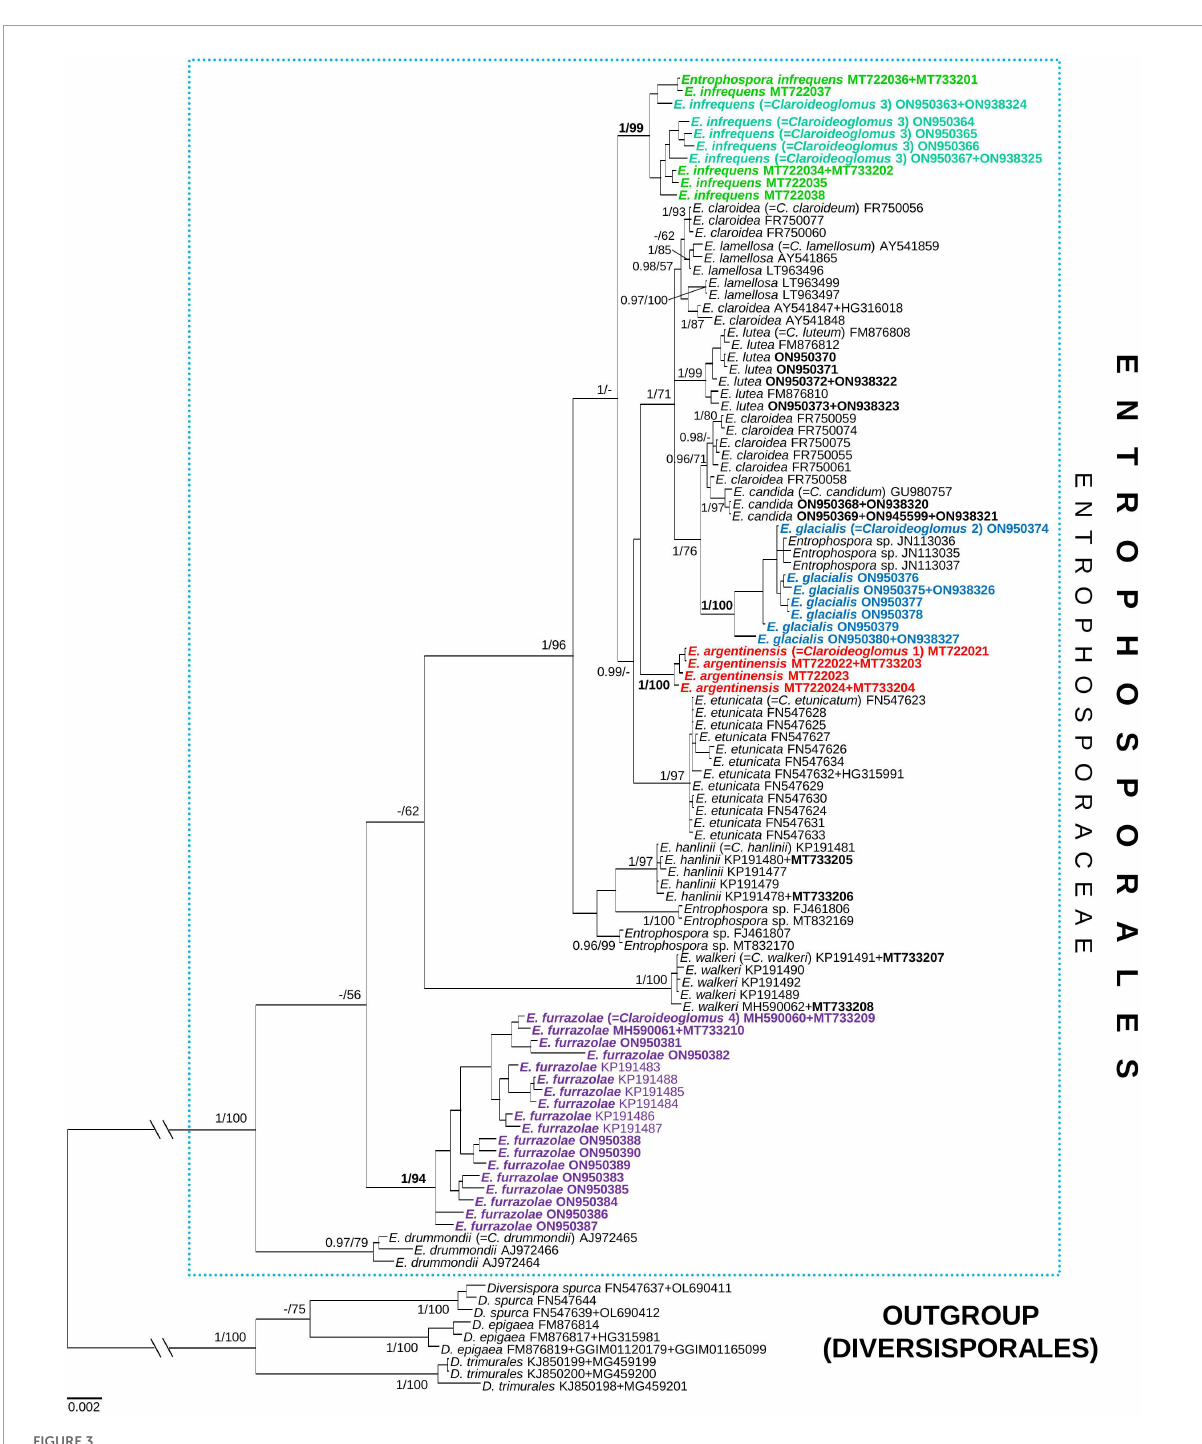
FIGURE3 A 50% majority-rule consensus tree from the Bayesian analysis of 45S nuc rDNA sequences concatenated with rpb1 sequences of Claroideoglomus 1, 2, 4 (newly described as Entrophospora argentinensis , E. glacialis , and E. furrazolae , respectively), Claroideoglomus 3 (a glomoid morph of the E. infrequens epitype), eight other species of Claroideoglomus sensu C. Walker and A. Schüßler, and three Diversispora species serving as outgroup. The former species names included in Entrophosporales are reported between brackets. The new species and the accession numbers of the sequences obtained in this study are in bold. The Bayesian posterior probabilities ≥ 0.90 and ML bootstrap values ≥ 50% are shown near the branches, respectively. Bar indicates 0.002 expected change per site per branch. The two basal branches were shortened to 20% in length to improve visibility (indicated by